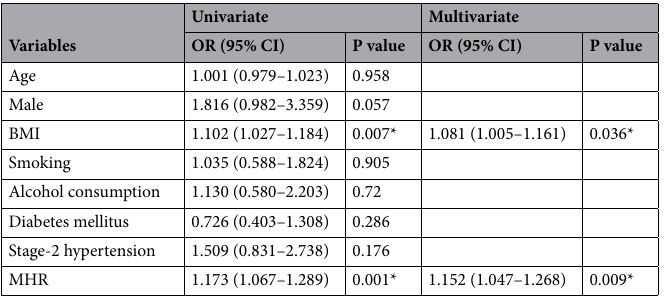
Table 4. Univariate and multivariate logistic regression analysis for the presence of OSA. BMI body mass index, MHR monocyte to high-density lipoprotein cholesterol ratio. *P value < 0.05.